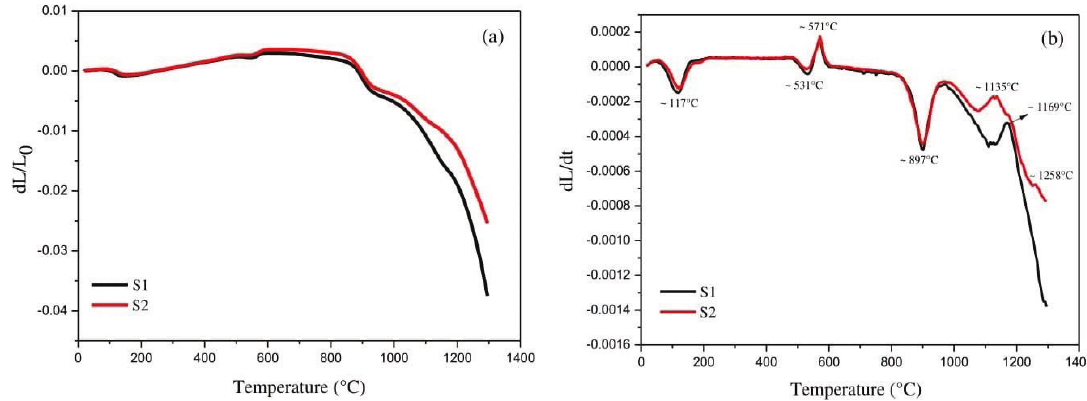
Figure 2. T hermal expansion curves of S1 and S2 green bodies heated to 1300ºC: (a) linear shrinkage curves, and (b) derivative